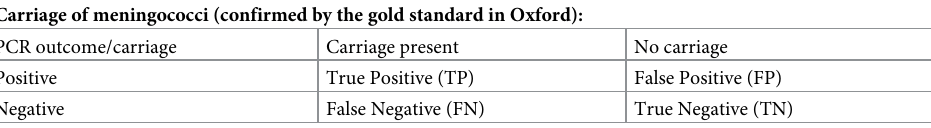
Table 3. Definition of sensitivity, specificity, positive predictive value and negative predictive